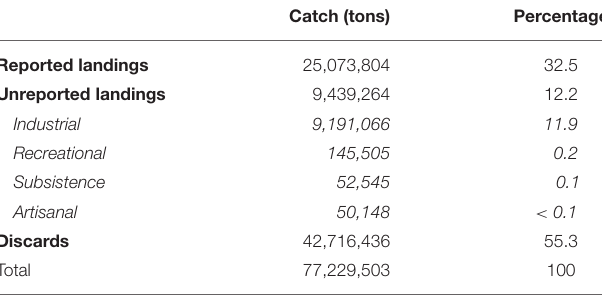
TABLE 5 | Summary of total reconstructed catch for the entire 1950-2014 period, broken down by component.